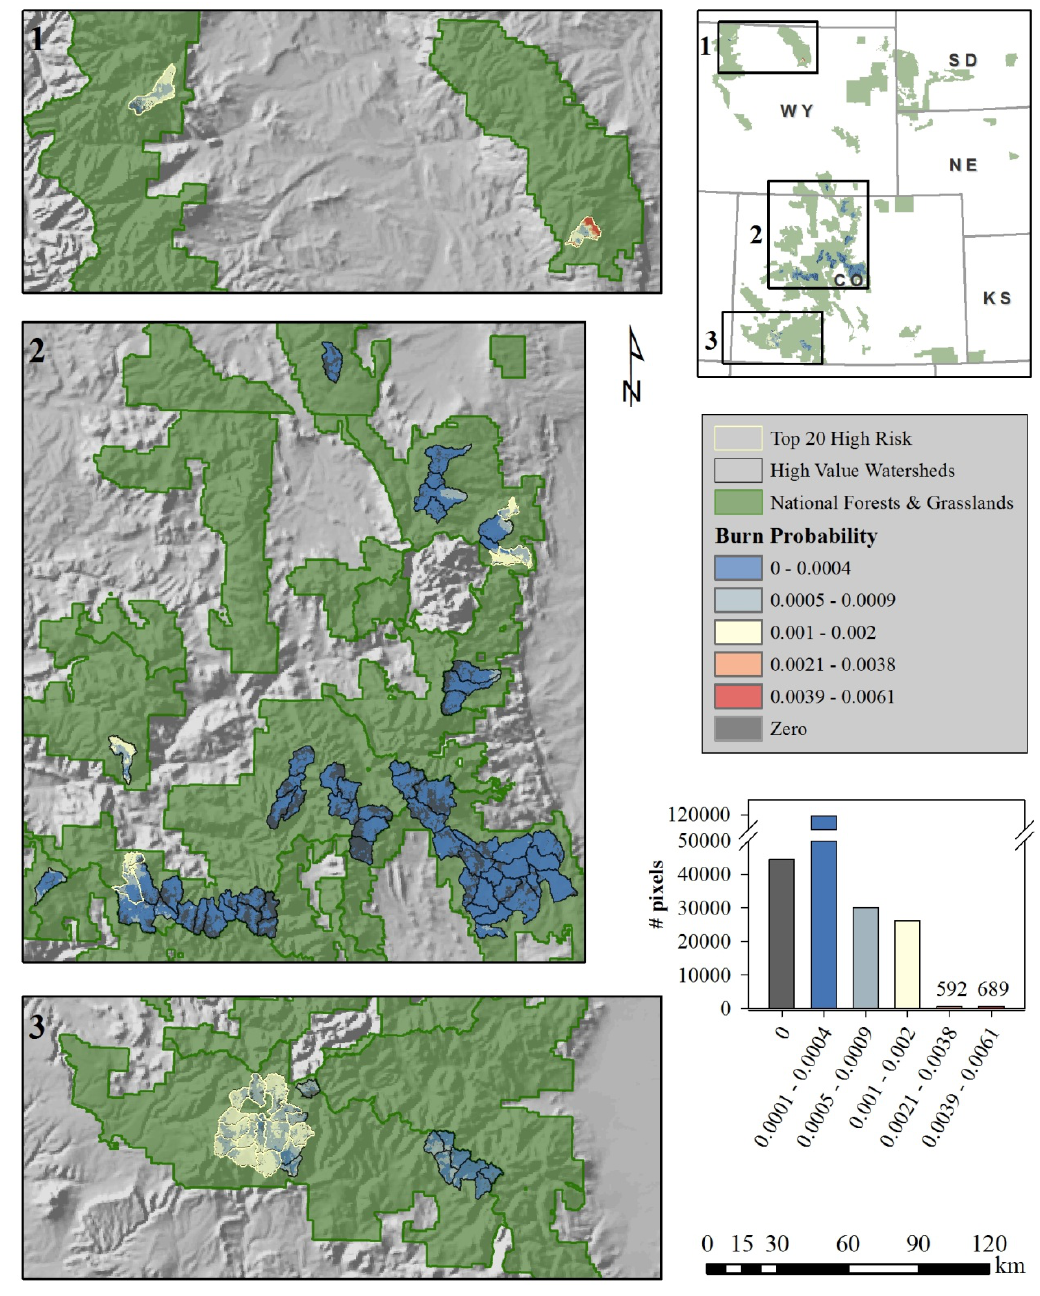
Figure 4. Annual Burn Probability ( BP ) values mapped across the assessed high value watersheds [See Equation (1)]. The top 20 high risk watershed boundaries are highlighted. CO = Colorado; KS = Kansas; NE = Nebraska; SD = South Dakota; WY =